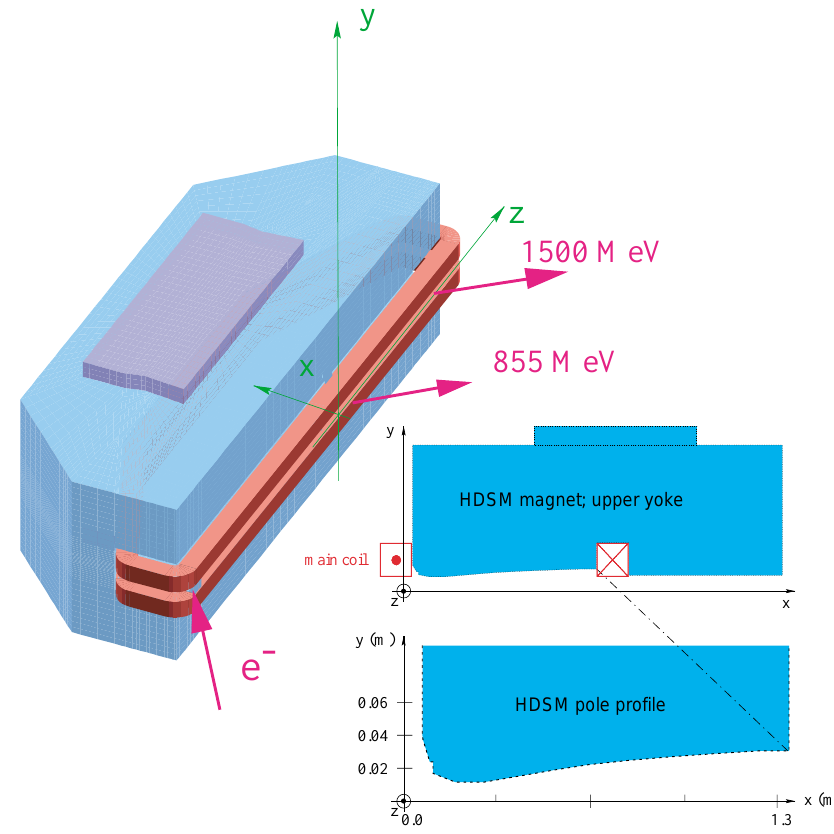
FIG. 1. (Color) Artist’s view and pole profile of a 90 ± HDSM bending